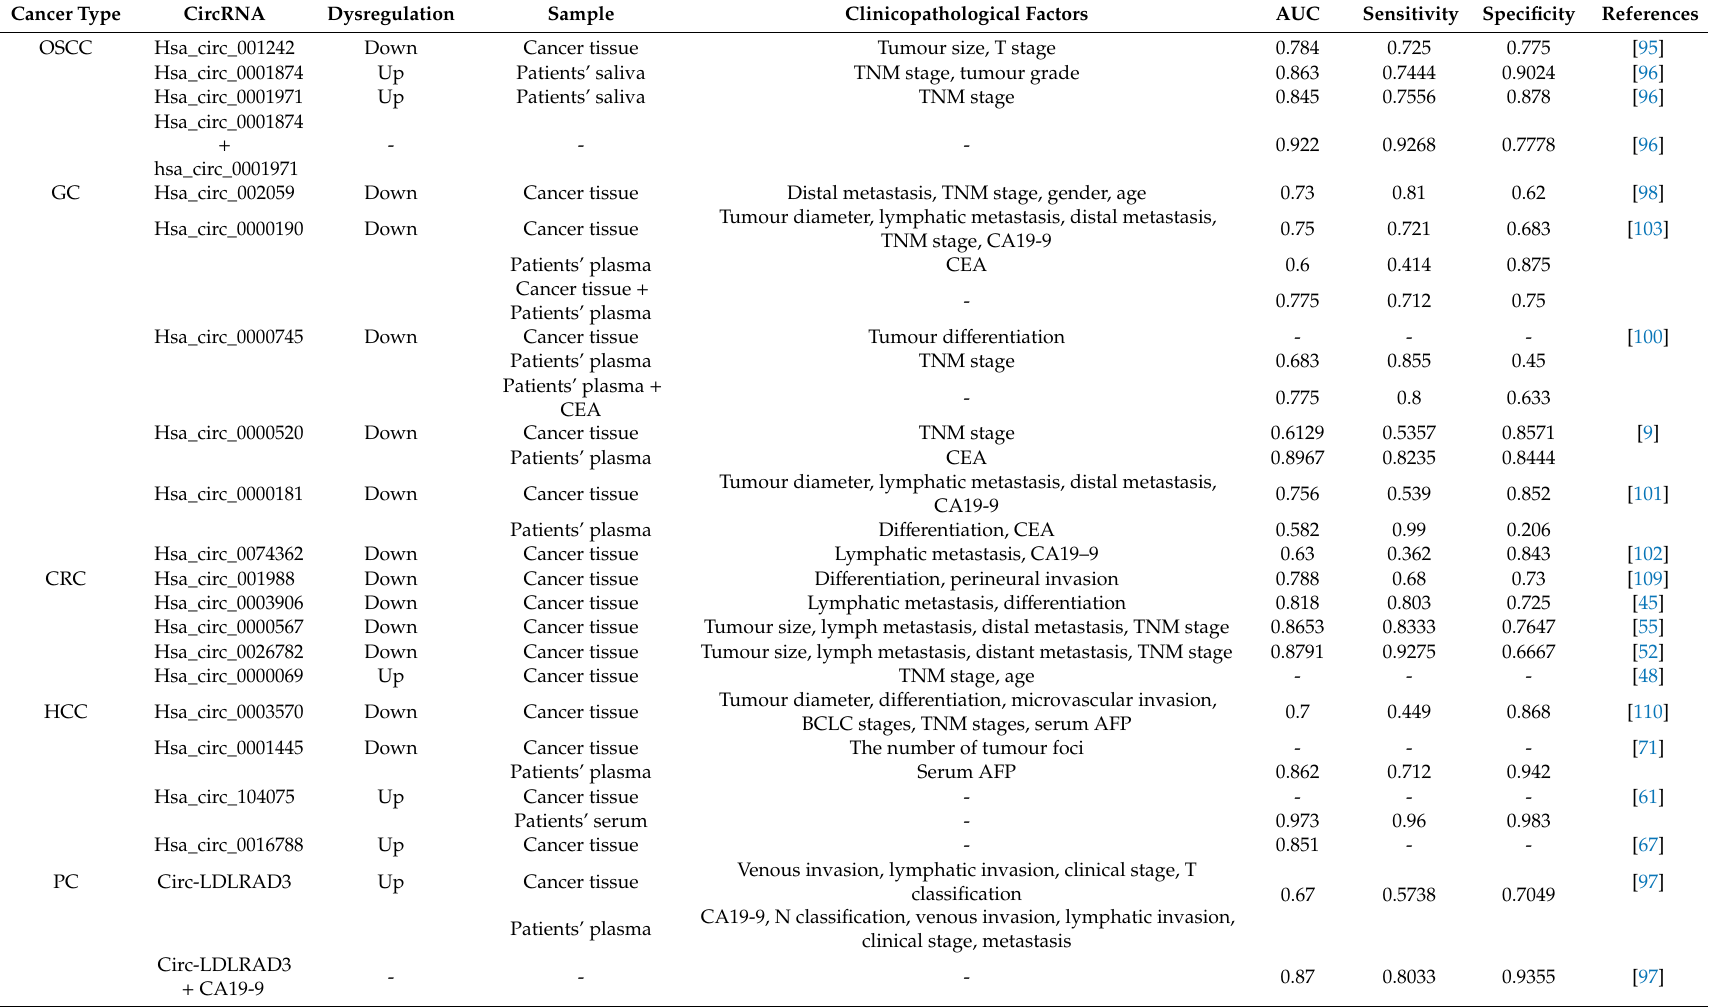
Table 5. The diagnostic value of circRNAs in digestive system